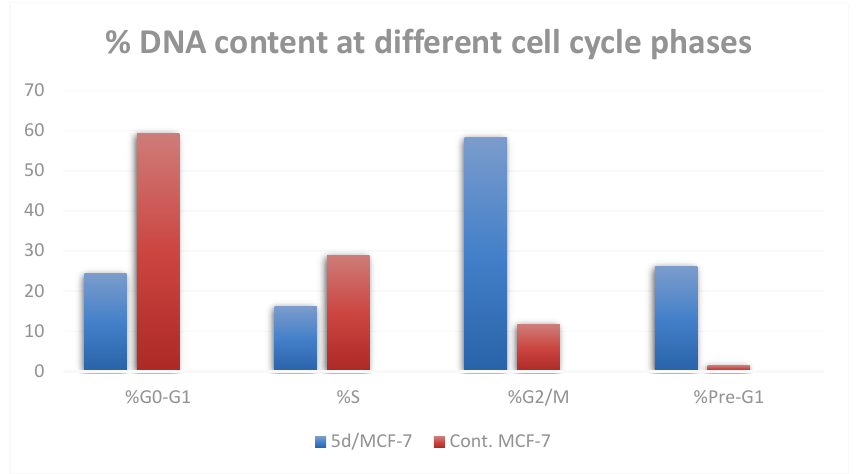
Figure 4. Cell cycle profile of MCF-7 cells after treatment with compound 5d.